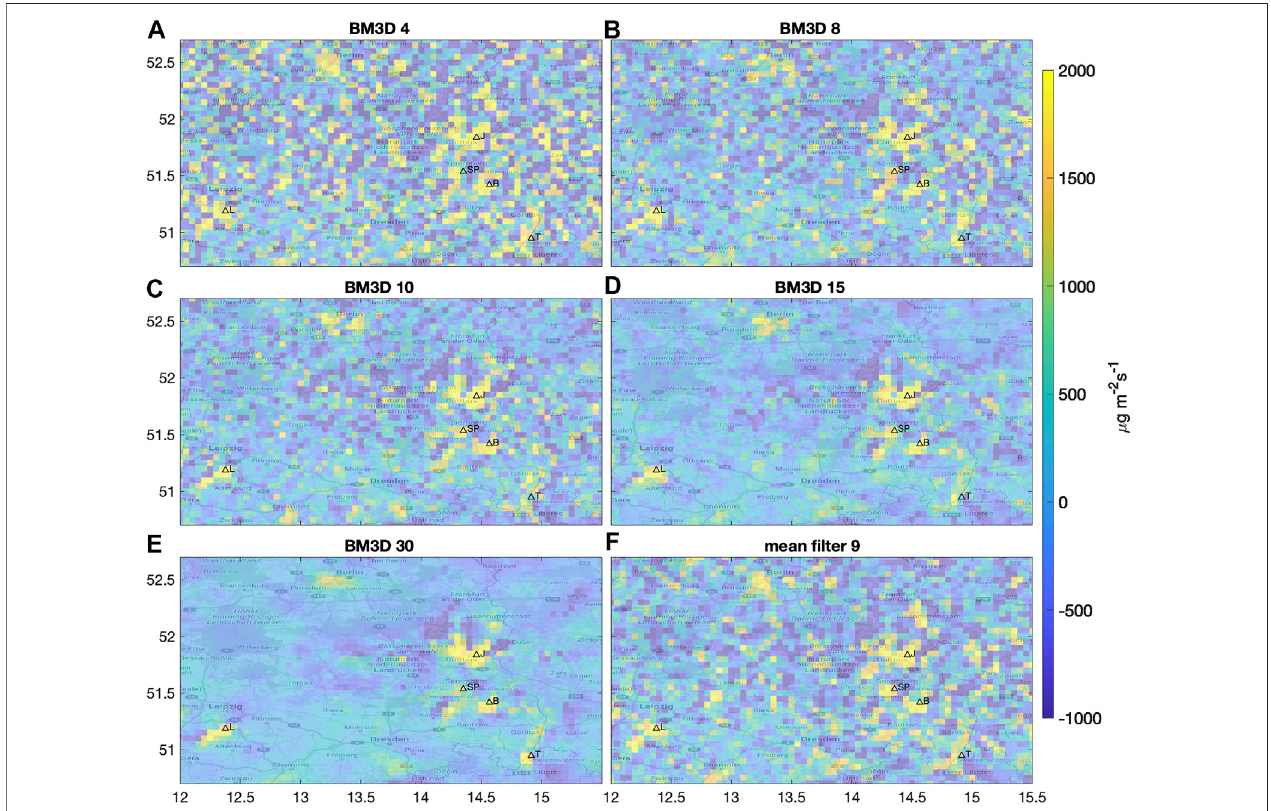
FIGURE 5 | CO 2 divergence calculated with different denoising methods. The different setups are indicated in the title of each panel. We tested the BM3D method with various denoising parameters ( σ BM3D = 4, 8, 10, 15, 30) as well as the mean fi lter with 3-by-3 kernel. See also Figure 3 for comparison.